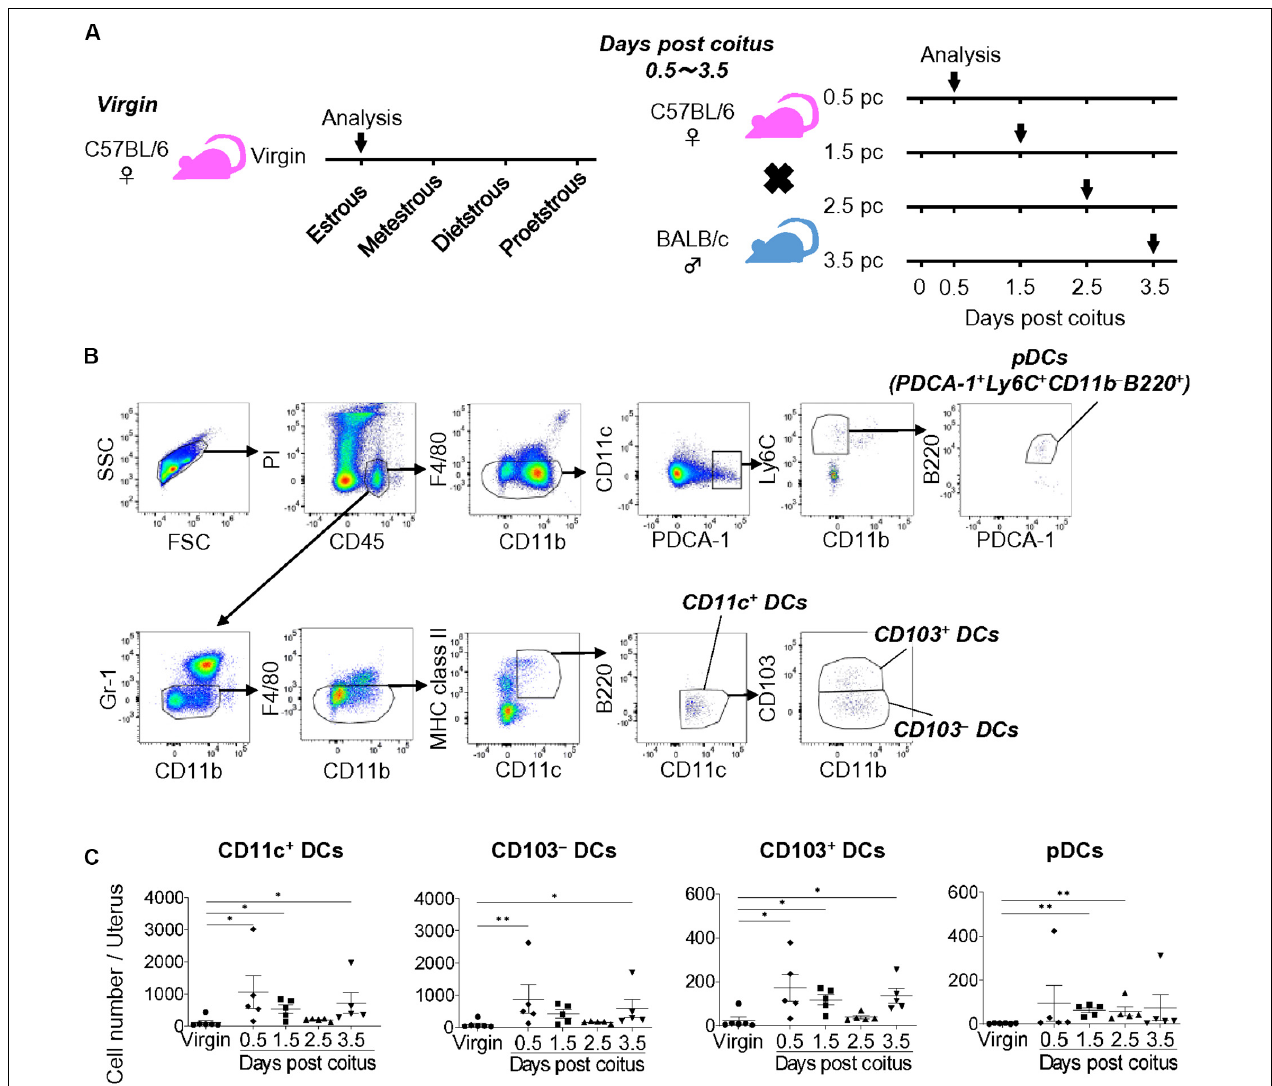
FIGURE 1 | Cell numbers of uDCs after coitus in allogeneic mating. (A) Experimental time course. The DCs in the uterus in non-mated control virgin mice and mice on days 0.5, 1.5, 2.5, and 3.5 pc were analyzed by flow cytometry. (B) Gating strategy was used to identify CD103 − DCs, CD103 + DCs, and pDCs in the uterus. (C) Graphs show number of CD11c + DCs and each DC subset in the uterus at each time point. A minimum of five samples from each time point were analyzed. Data represent mean ± SEM and are representative of three independent experiments. Statistical comparisons were performed using Kruskal-Wallis test with Dunn’s multiple comparisons test ( ∗∗ P < 0.01, ∗ P <